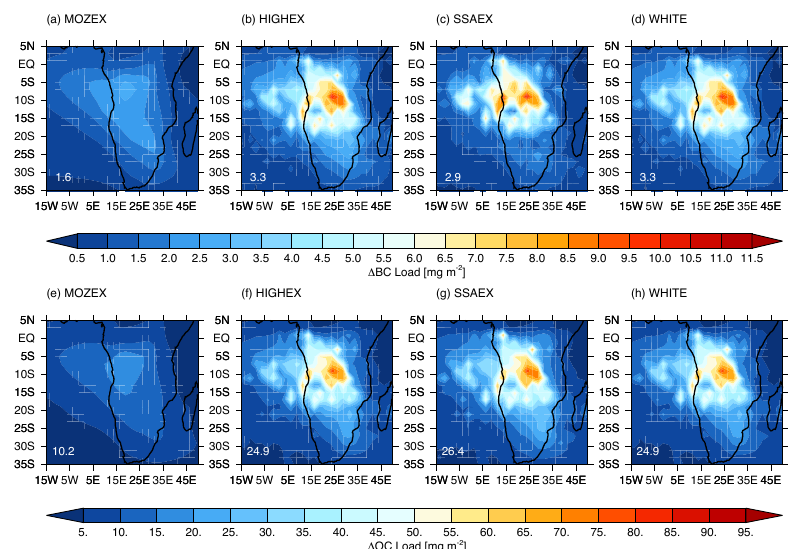
Fig. 2. ASO black carbon (BC) column load [mgm − 3 ] for (a) MOZEX, (b) HIGHEX, (c) SSAEX, and (d) WHITE. ASO organic carbon (OC) column load [mgm − 3 ] for (e) MOZEX, (f) HIGHEX, (g) SSAEX, and (h) WHITE. Note that HIGHEX and WHITE have the same BC and OC distributions, but in WHITE both BC and OC are treated optically as scattering-only aerosols as described in the text. Land-area average column load is given in the bottom left of each panel for the region (3 ◦ N–37 ◦ S, 19 ◦ W–50 ◦